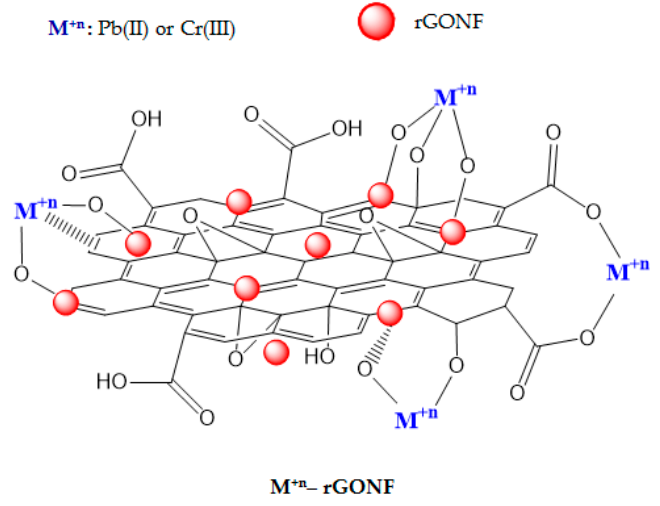
Figure 5. The possible adsorption mechanism of metal ions with rGONF.